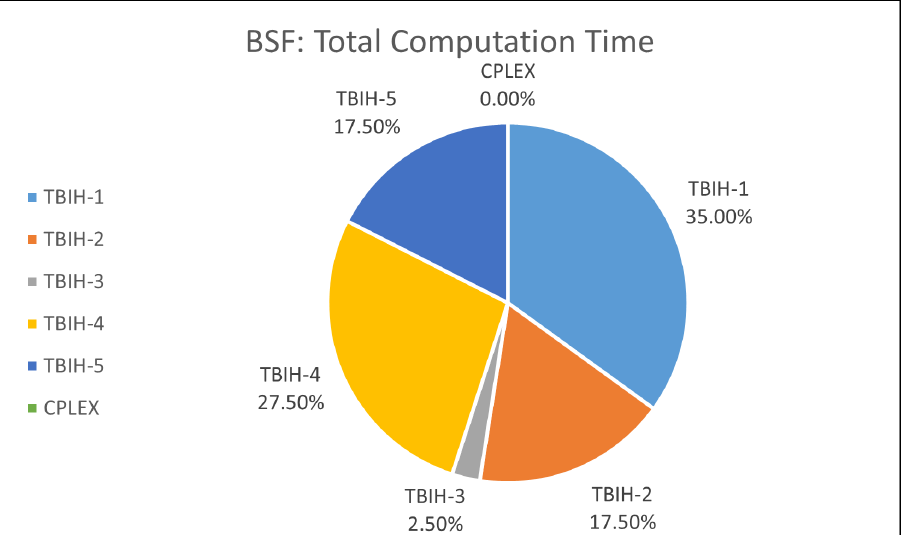
Figure A22. Algorithms performance compared to matheuristic rollout applied in PDS-RA: total BSF measured for total computation time over all test instances applied (omitting 10 non-benchmarked aasurements).